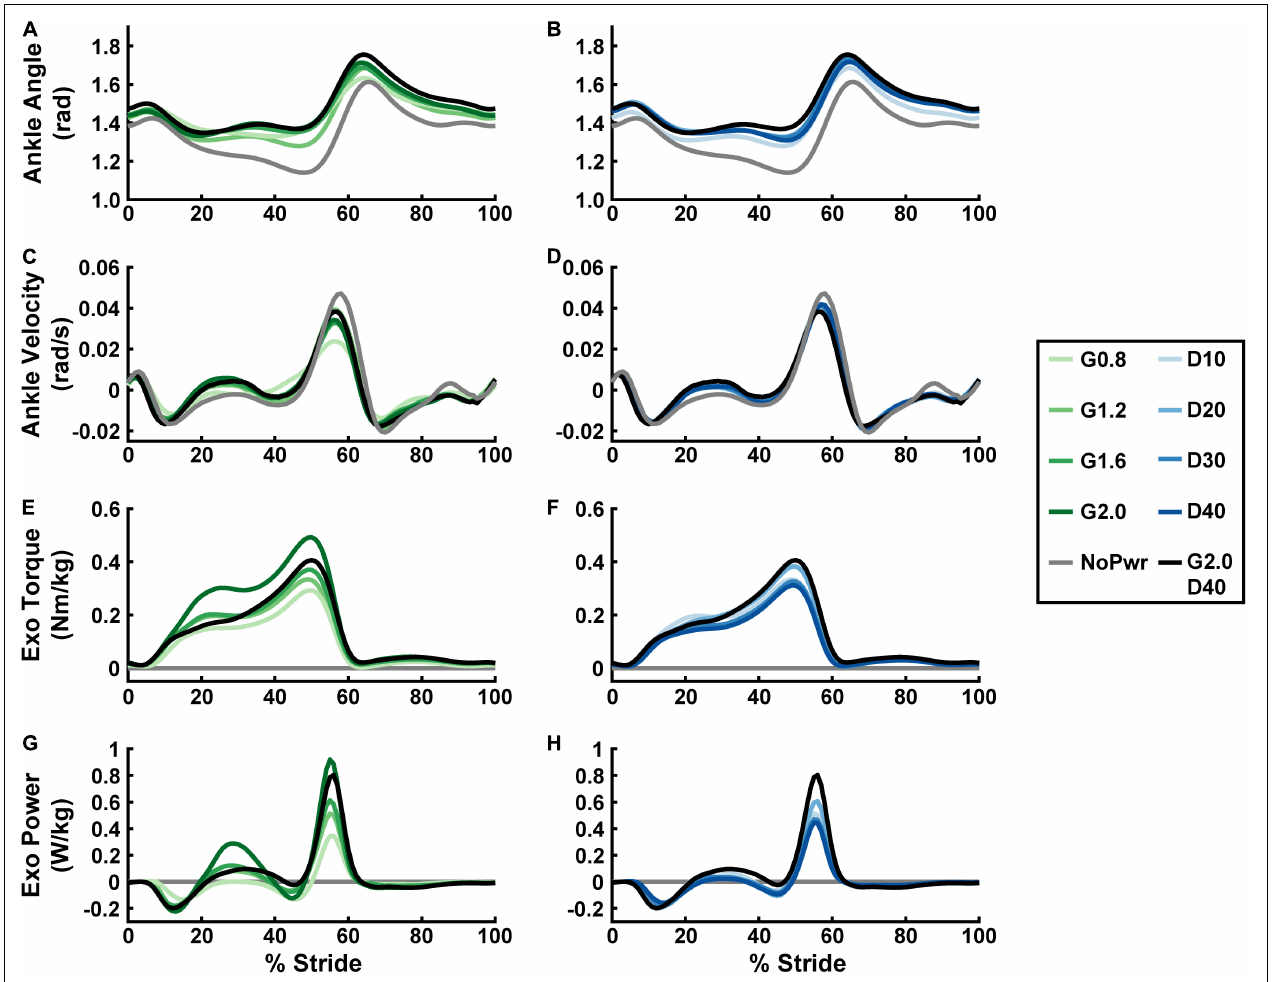
FIGURE 2 | Users’ ankle joint kinematics, and exoskeleton mechanics over a stride cycle. Measurements of users’ ankle angle (A,B) , ankle angular velocity (C,D) , ankle exoskeleton torque (E,F) , and ankle exoskeleton mechanical power (G,H) over a stride from heel strike (0%) to heel strike (100%) of the same leg are shown. Ankle plantarflexion is depicted as positive and dorsiflexion as negative for the angle, angular velocity, and torque plots. Positive/negative power indicates net energy transfer from exoskeleton to user and vice versa. All measurements are averages across the study participants ( N = 9) in each condition with varying neuromuscular model (NMM) controller reflex Gain (green) in left panel (A,C,E,G) and Delay (blue) in the right panel (B,D,F,H) . Conditions are abbreviated and color coded as follows: unpowered (NoPwr) (gray), NMM reflex Gains of 0.8, 1.2, 1.6, and 2.0 all with reflex Delay = 10 ms (G0.8, G1.2, G1.6, and G2.0, respectively) (green), NMM reflex Delays of 10, 20, 30, and 40 ms all with a reflex Gain = 1.2 (D10, D20, D30, D40, respectively) (blue), and a high-Gain-high-Delay condition (G2.0 D40)